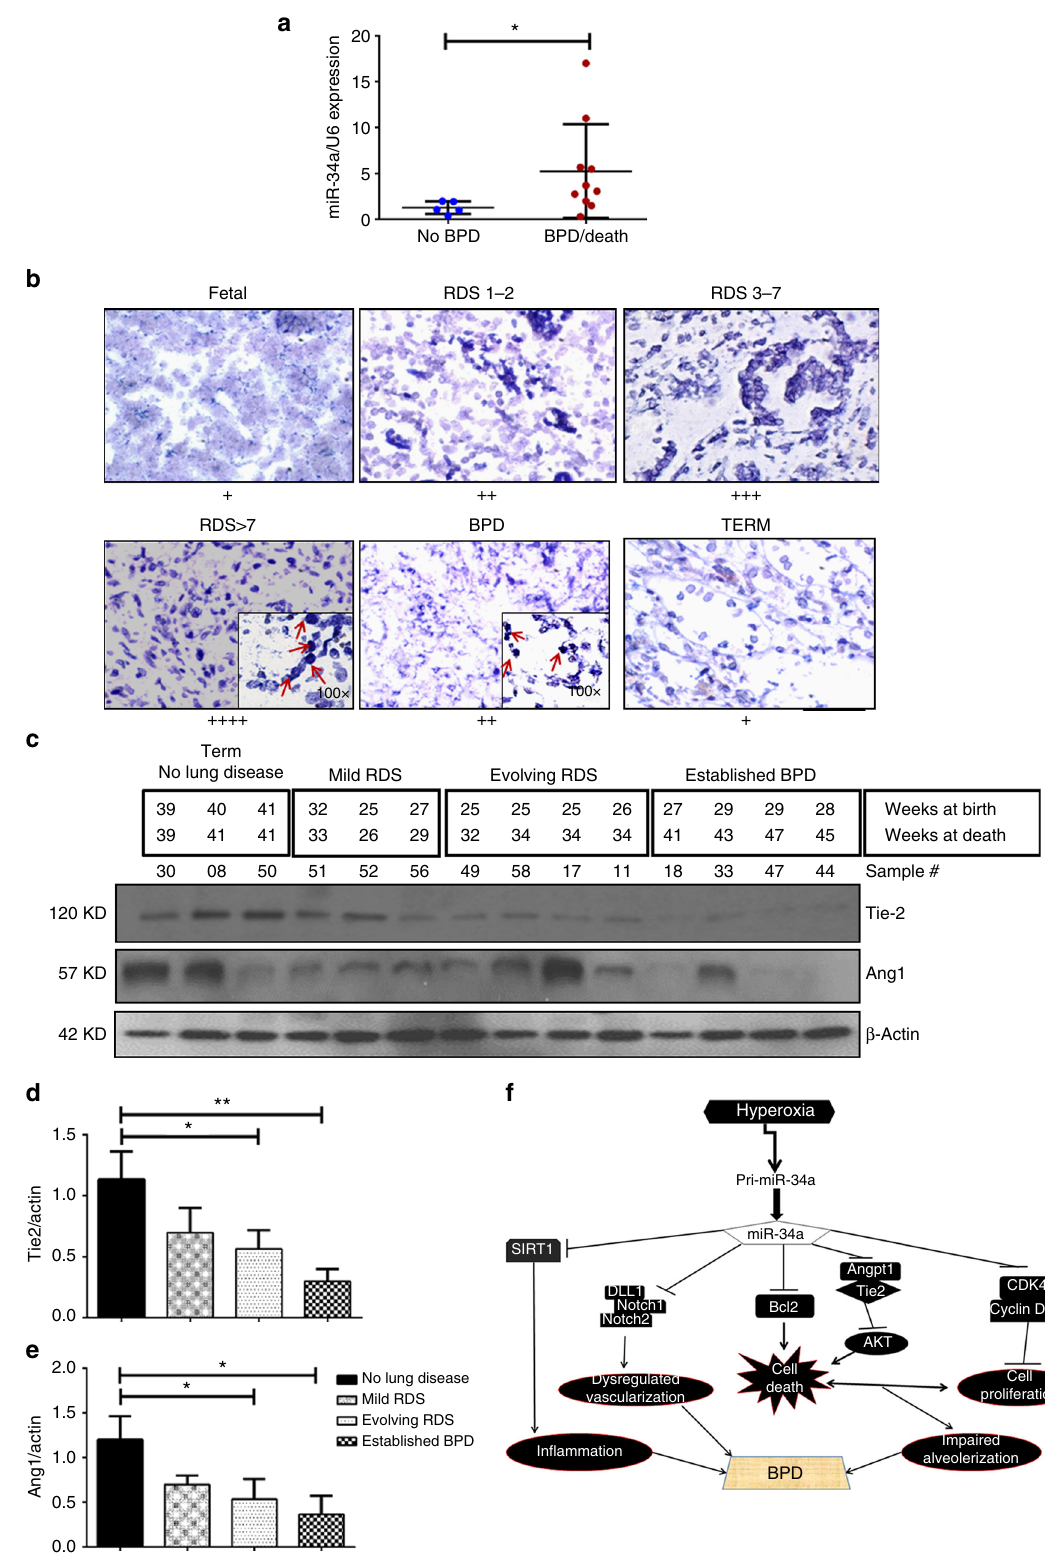
standard food and water. All animal experiments proceeded in accordance with NIH policies and were approved by the Institutional Animal Care and Use Committees (IACUCs) at Yale and Drexel Universities. Both male and female newborn mice were used for the experiments, at speci fi c postnatal ages, as noted in the fi gure